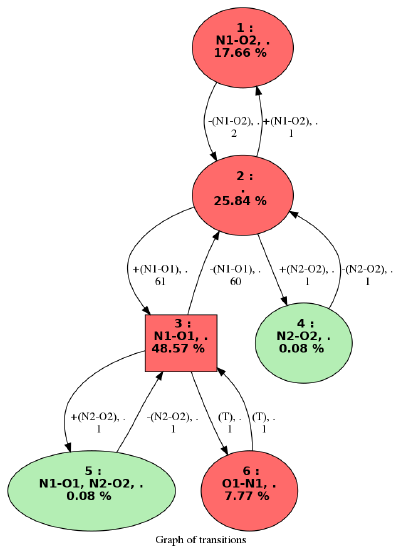
Figure 3. Example of a graph of transitions for a trajectory of NH + peptide in the gas phase. See text for the nomenclature and